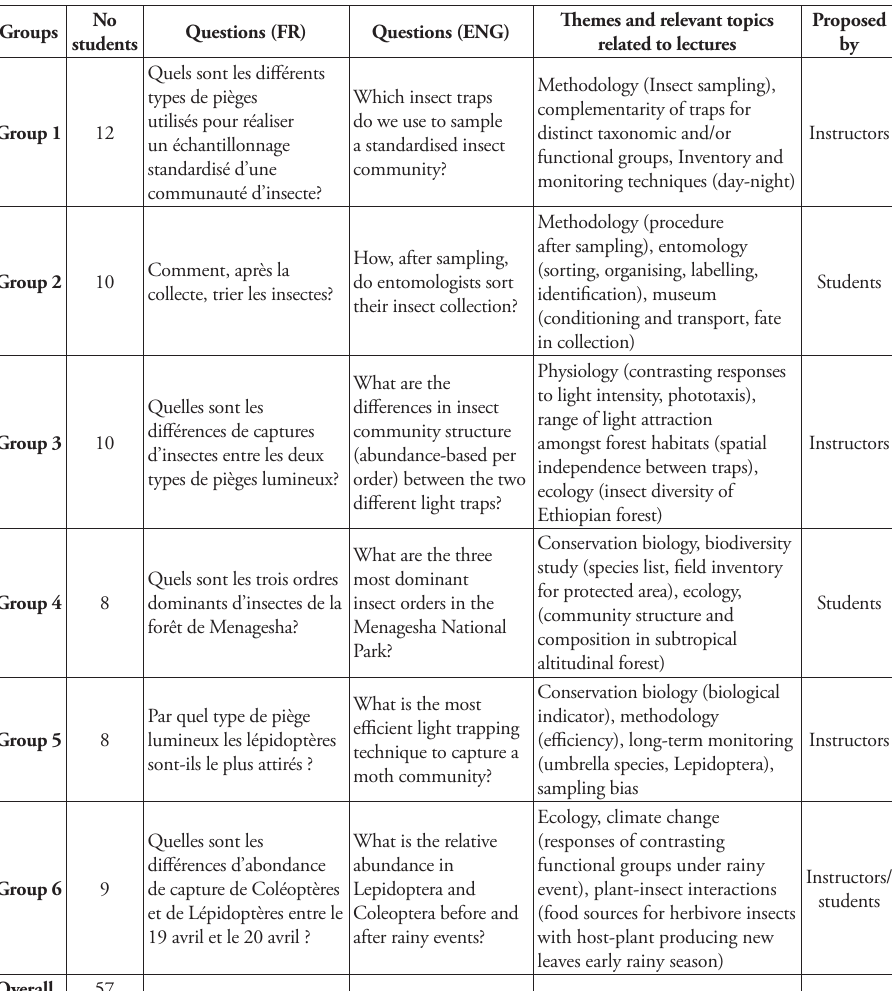
Table 1. Scientific questions proposed and examined by each of the six groups during the programme Des Insectes et des Hommes with the themes and topics relevant to the questions.